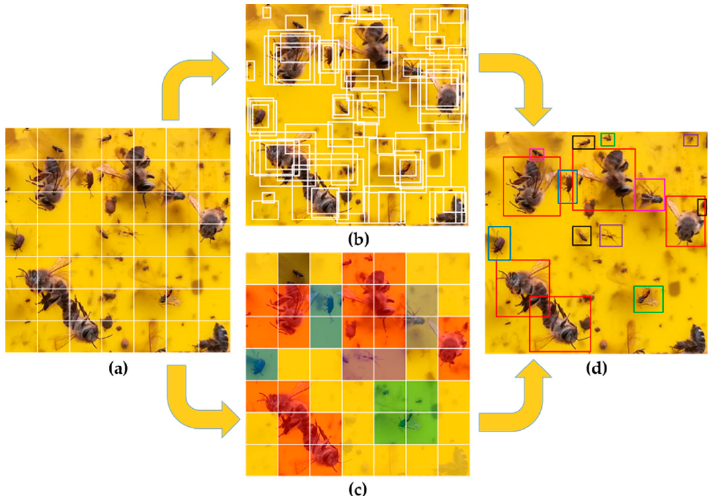
Figure 4. Detection model of YOLO ( a ) Divided in to cells with equal size; ( b ) The predicted bounding boxes of cell; ( c ) Class probability map; ( d ) Final detection of YOLO.